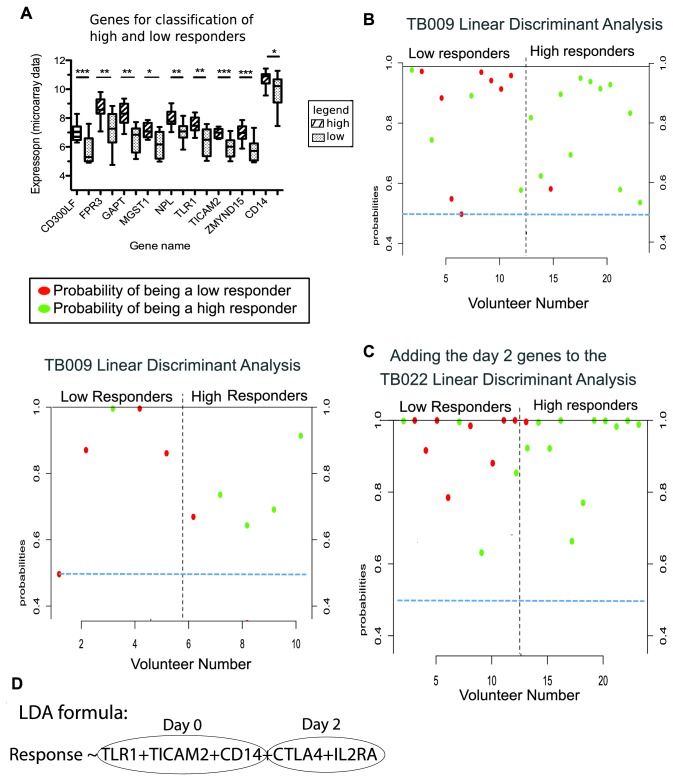
Expression of genes on day of vaccination and 2 days later can classify high and low responders.Cohorts: TB022: 24 volunteers used in the original microarray analysis. TB009: 10 volunteers from a previous trial of MVA85A who received an equivalent dose used in the qPCR validation. A. Exploratory list of 9 genes obtained from the prediction analysis done on the microarray data from TB022 B. Probability plots of linear discriminant analysis classification outcomes of high and low responders in trials TB022 and TB009 from expression of TLR1, TICAM2 and CD14 on day of vaccination. C. Probability plot of LDA classification outcome of TB022 volunteers when CTLA4 and IL2RΑ expression on day 2 are added to the model (Other genes, eg CD5 and STAT5B were removed as they did not add predictive value to the model due to co-linearity with other genes). D. Hypothesis resulting from LDA analyses.